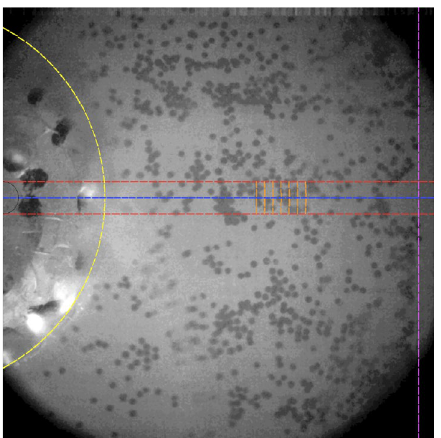
Figure 6. Schematic representation of the elements involved in the particle tracking method. The contour of the disk emitter and the stiff inclusion are coloured in yellow and purple, respectively. The area of interest for reconstructing the particle displacement due to the shear wave propagation falls between the two red dashed lines. The blue line represents the line of analysis. Examples of sections for calculating the cross-correlation are shown in